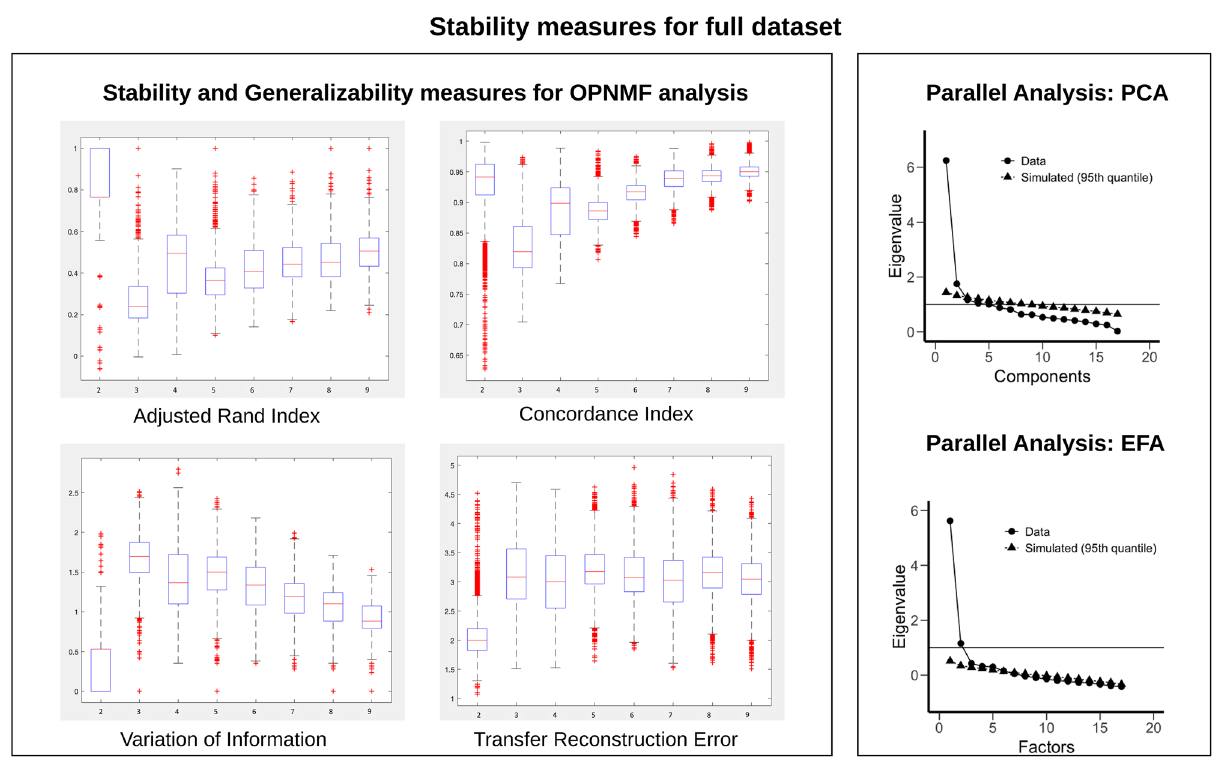
Figure 1. Stability measures for full dataset. Left panel shows plots for each of the stability measures used to identify the most robust factor solution for the OPNMF analysis. The right panel shows plots for the parallel analyses used to identify the most robust component/factor solutions in the PCA and EFA